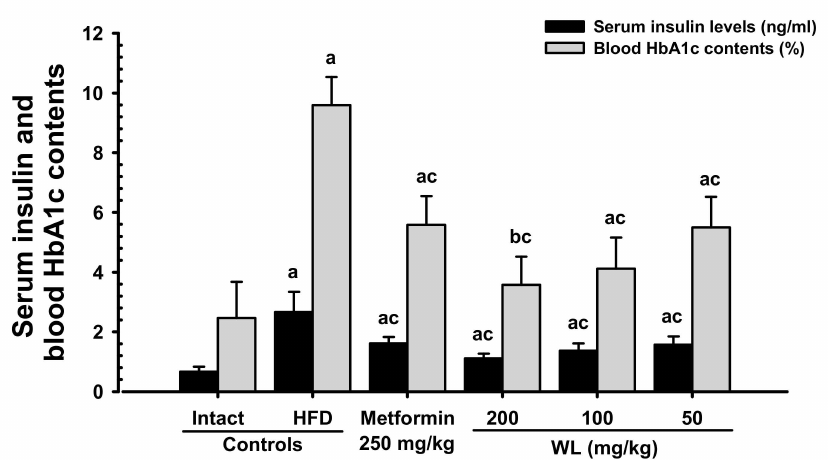
Figure 6. Serum insulin and blood HbA1c contents in NFD or HFD supplied mice. Values are shown